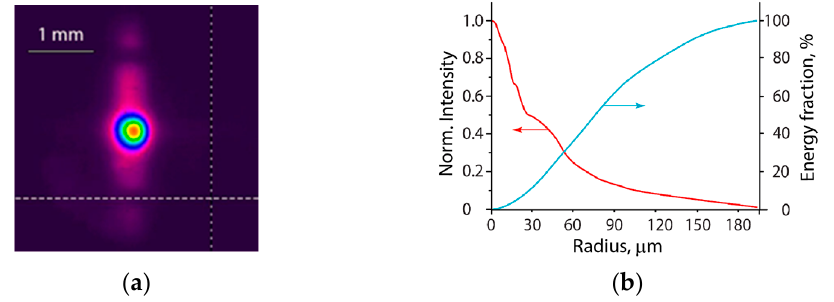
Figure 2. ( a ) Beam profiler image of the focal spot obtained with UV converter and ( b ) normalized distributions of intensity (red curve) and energy fraction (blue curve) in the focal spot.